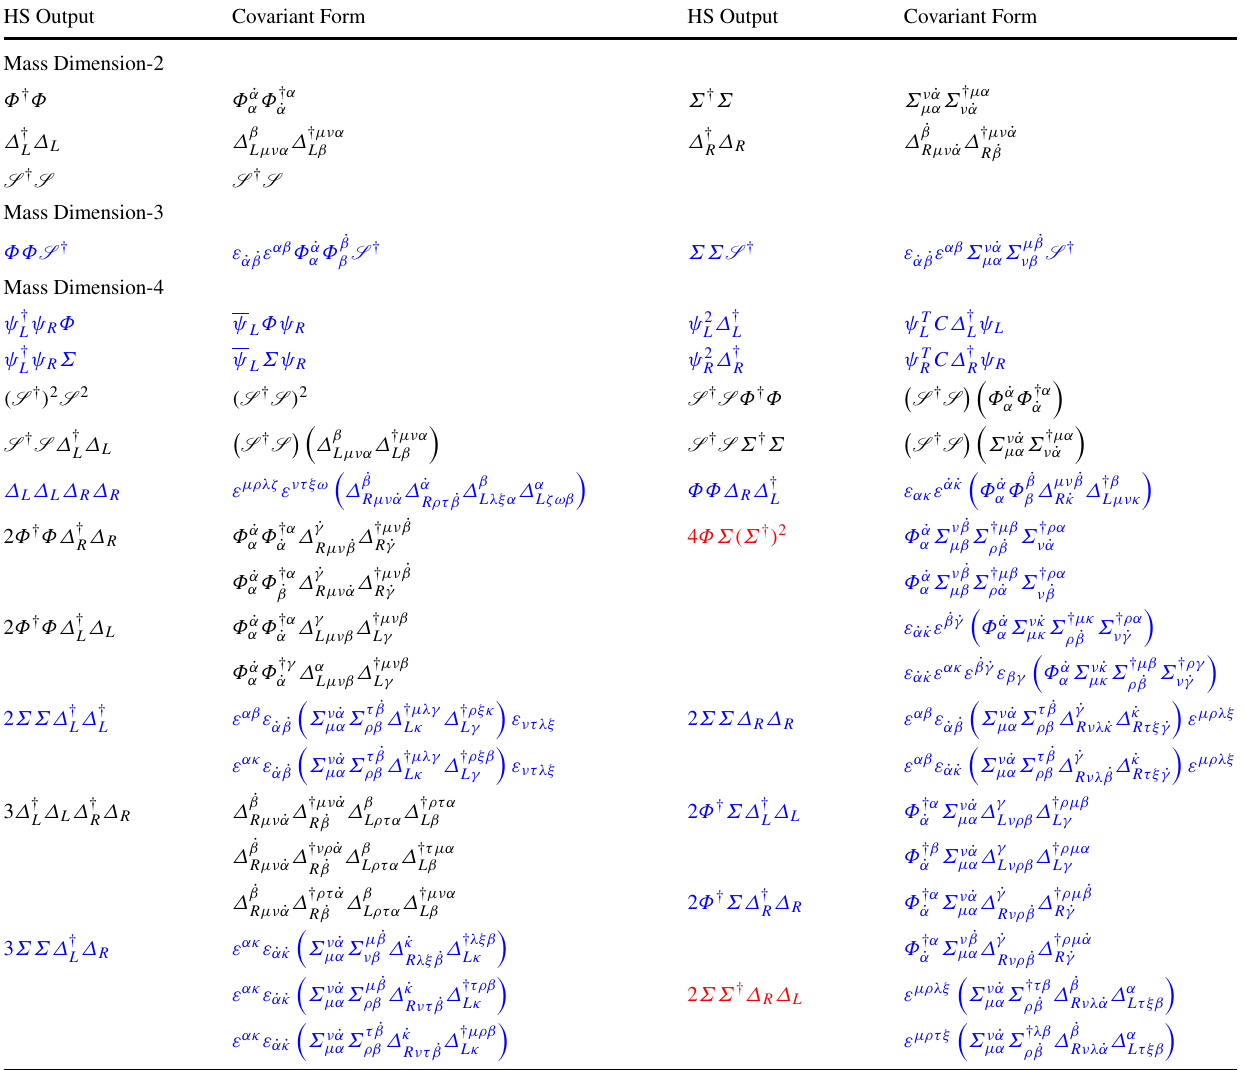
Table 7 Pati-Salam model: renormalizable operators as Hilbert Series output and their covariant form. The operators in blue have distinct hermitian conjugates which we have not written explicitly continued. We have suppressed the indices in the Yukawa terms. Notation for the